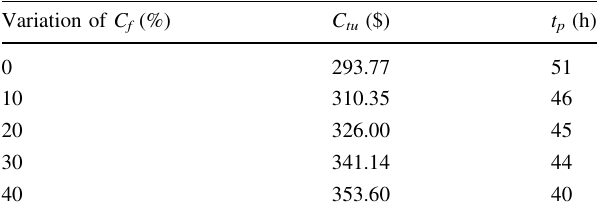
Fig. 5 Optimal drill bit replacement time Table 2 Results of sensitivity analysis Variation of C f (%)